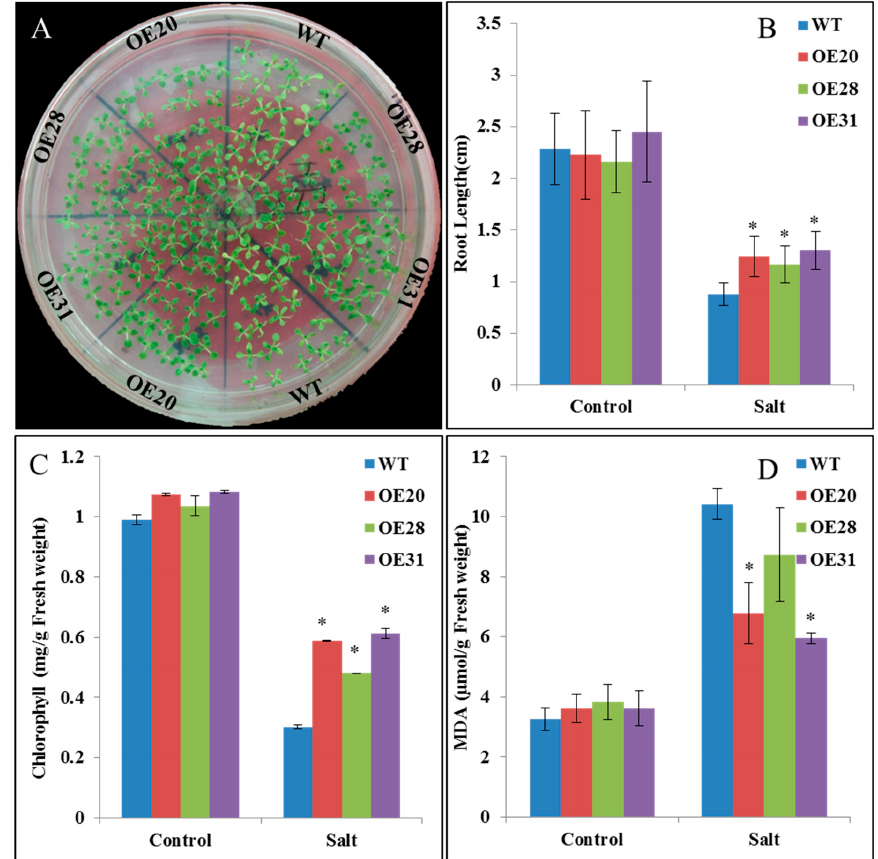
Figure 6. The overexpression (OE) of PKE1 in tobacco enhanced its salt tolerance. ( A ) OE of tobacco SpPKE1 lines and wild type (WT) subjected to 200 mM NaCl. The image was captured after 7 days of treatment. The root length ( B ), contents of chlorophyll ( C ), and malondialdehyde (MDA) ( D ) changes subjected to 200 mM NaCl (Salt) and absence of NaCl (Control) in transgenic and WT plants after 12 days of treatment. All data presented as means ± SE, *, Means differ p < 0.05.